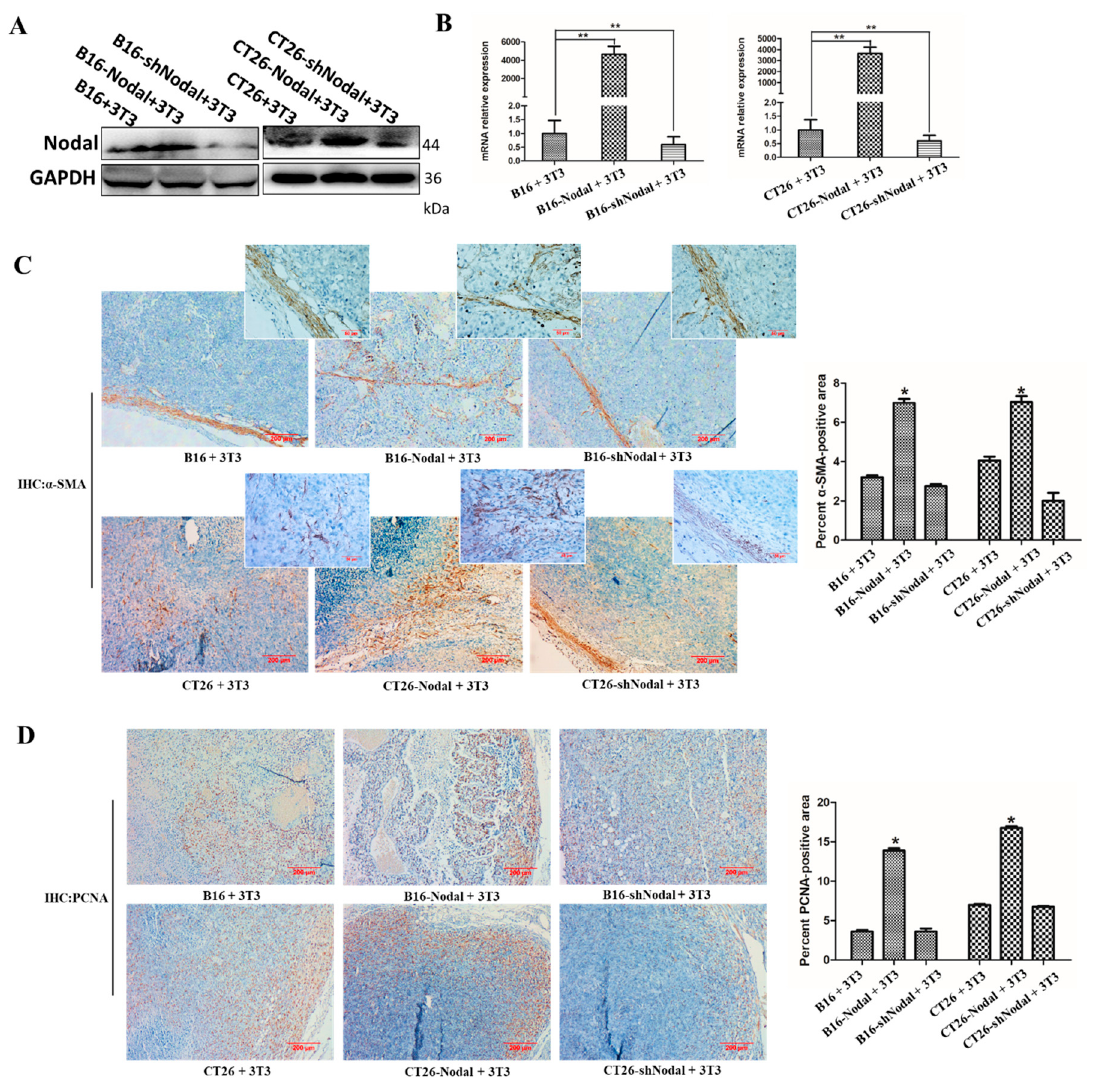
Figure 5. The distribution of CAFs and the expression of PCNA in the tumor tissue sections. ( A ) Western blotting of Nodal and TGF- β in xenograft tissues. GAPDH served as the loading control. ( B) The mRNA level of Nodal in xenograft tissues was detected by real-time PCR. ( C ) Representative images of α -SMA-stained para ffi n sections of B16 and CT26 tumor tissues were shown ( × 100; left) and quantitatively analyzed by ImageJ (right). The figures in the top right corner were enlarged ( × 400). ( D ) Representative images of PCNA staining in para ffi n sections were shown ( × 100; left) and quantitatively analyzed by ImageJ (right). * p < 0.05, ** p <